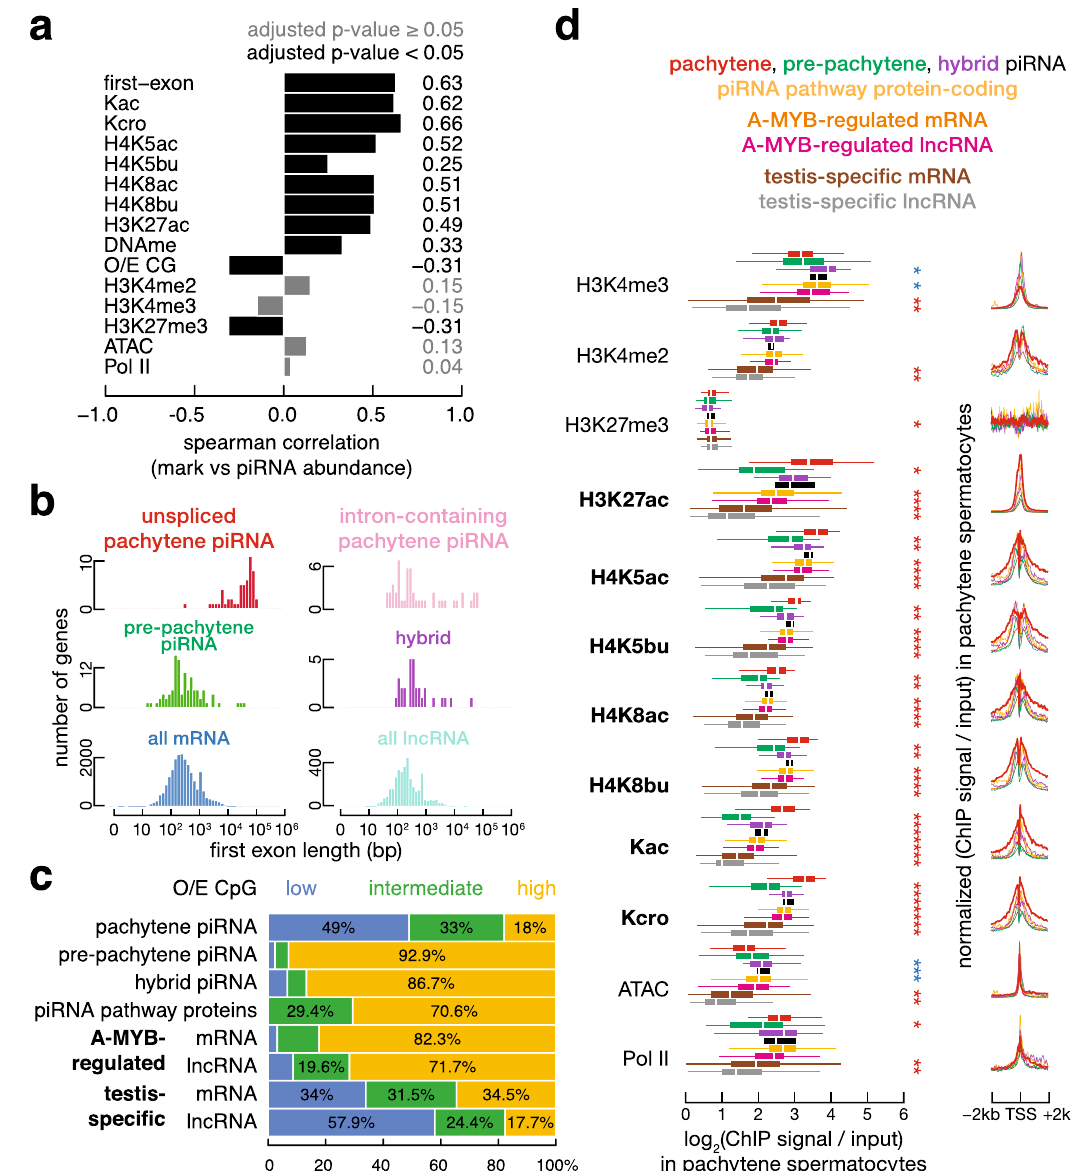
Fig. 2 Low-CG promoter, long- fi rst-exon or long intronless gene, and high histone acylation correlate with the production of pachytene piRNAs. a Bar plot reports the Spearman correlation coef fi cient between piRNA abundance and fi rst exon length and promoter O/E CG, H3K4me3, H3K27me3, H3K4me2, H3K27ac, H4K5ac, H4K5bu, H4K8ac, H4K8bu, pan-lysine acetylation (Kac), pan-lysine crotonylation (Kcro), chromatin accessibility measured by ATAC-seq, DNA methylation, and RNA pol II binding at the promoters (TSS ± 2 kb) of pachytene piRNA clusters in pachytene spermatocytes. Signi fi cant correlations (Benjamin-adjusted p values < 0.05; n = 100) are marked in black, while nonsigni fi cant correlations are marked in grey. b Histograms of fi rst exon length of intronless pachytene piRNA clusters and the fi rst exons of intron-containing pachytene piRNA clusters, pre-pachytene piRNA clusters, hybrid piRNA clusters, all protein-coding genes, and all lncRNAs. c The percentages of low-CG, intermediate-CG, and high-CG promoters. Eight groups are shown: pachytene piRNA clusters, pre-pachytene piRNA clusters, hybrid piRNA clusters, piRNA pathway genes, A-MYB-regulated protein-coding genes, A-MYB-regulated lncRNA genes, testis-speci fi c protein-coding genes, and testis-speci fi c lncRNA genes. d . Boxplots and meta-gene plots show histone modi fi cations, ATAC, and RNA pol II levels at 100 pachytene piRNA clusters, 84 pre-pachytene piRNA clusters, 30 hybrid piRNA clusters, 17 piRNA pathway genes, 789 A-MYB-regulated protein-coding genes, 46 A-MYB-regulated lncRNAs, 1171 testis-speci fi c protein-coding genes, and 164 testis-speci fi c lncRNAs in pachytene spermatocytes. The x -axis for the box and the y -axis for the meta-gene plots report log 2 ChIP signal or ATAC- seq read coverage relative to input, using a pseudo-count of 1. Asterisks indicate statistical signi fi cance (two-sided Wilcoxon rank-sum test p value < 0.001) for pairwise comparisons between 100 pachytene piRNA clusters and each of the other gene types. Red (blue) indicates that the epigenetic level is signi fi cantly higher (lower) in pachytene piRNA clusters. For boxplots, whiskers show 95% con fi dence intervals, boxes represent the fi rst and third quartiles, and the vertical midline is the